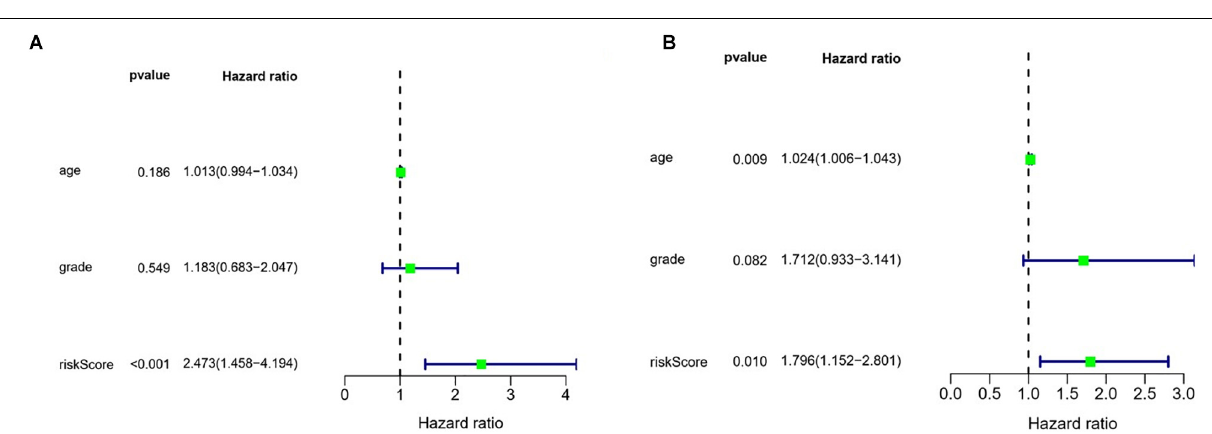
FIGURE 9 | Evaluation of the prognostic value of different clinical parameters by univariate analysis. (A) Training cohort. (B) Test